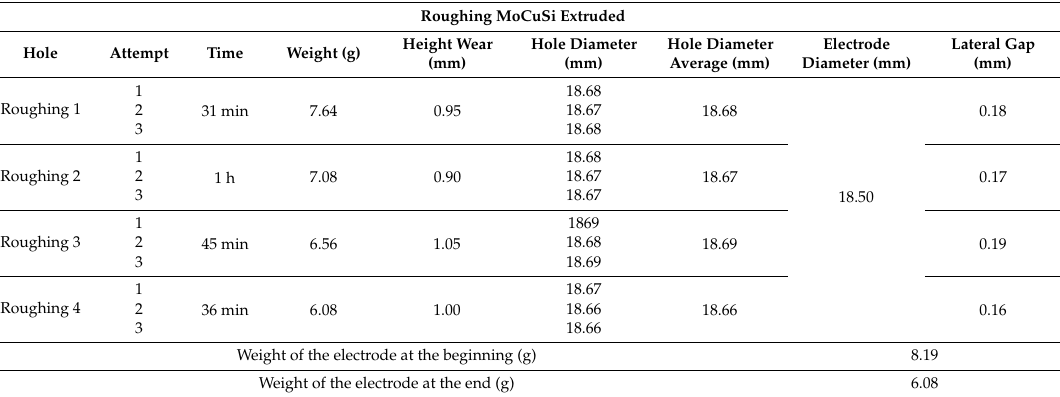
Table 9. Roughing results for the extruded MoCuSi.